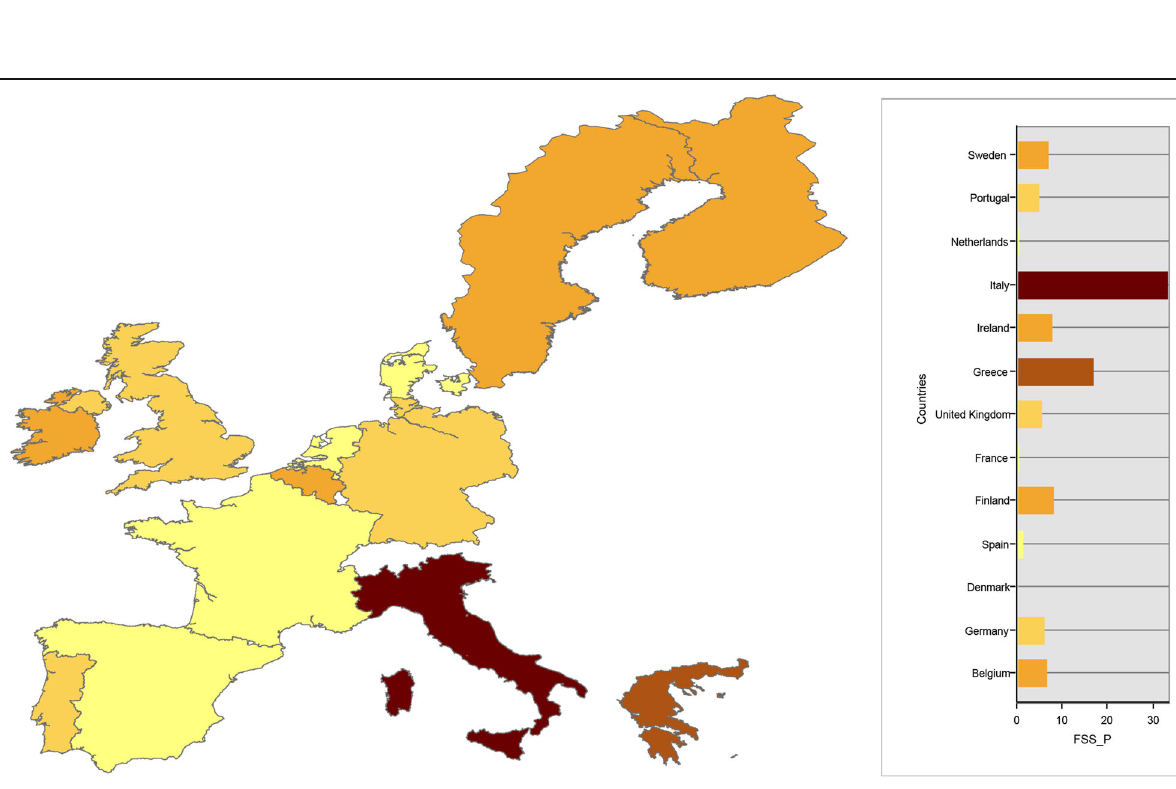
Fig. 6 Detainable remarks percentage for FSS Code for EU15